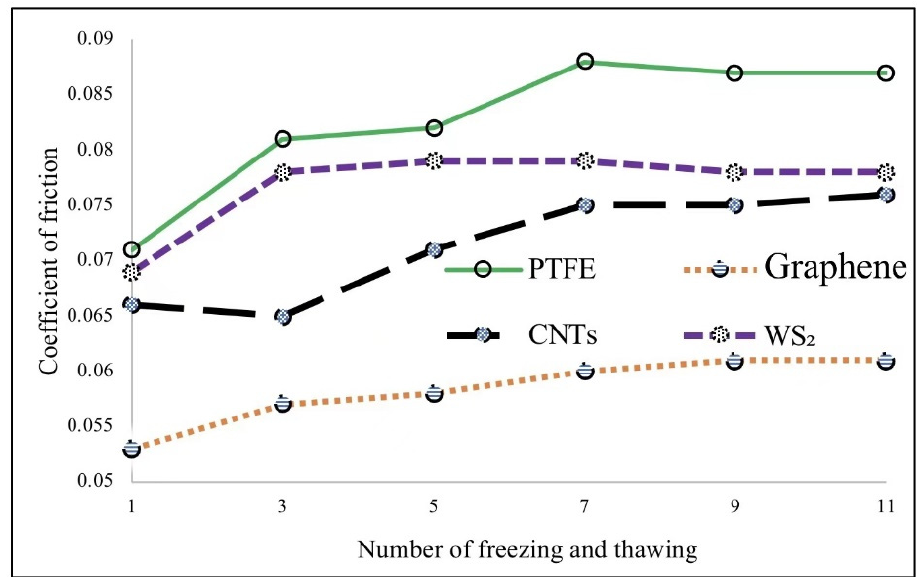
Figure 3. Friction coefficient of grease after freeze–thawing.